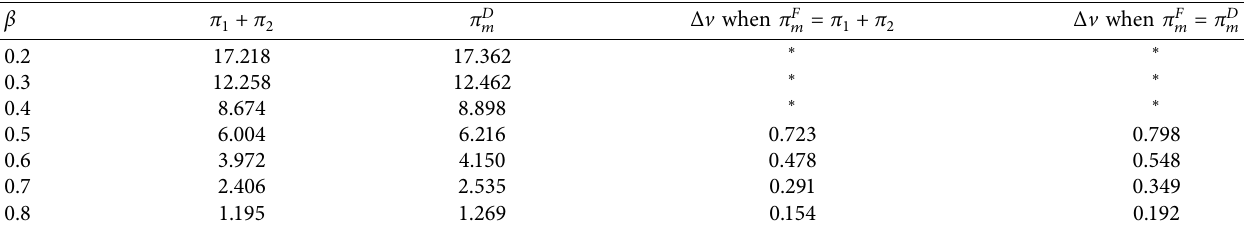
Figure 2: Comparison of the equilibrium results before and after the merger with β . Table 1: Comparison of the profit of the postmerger manufacturer under different